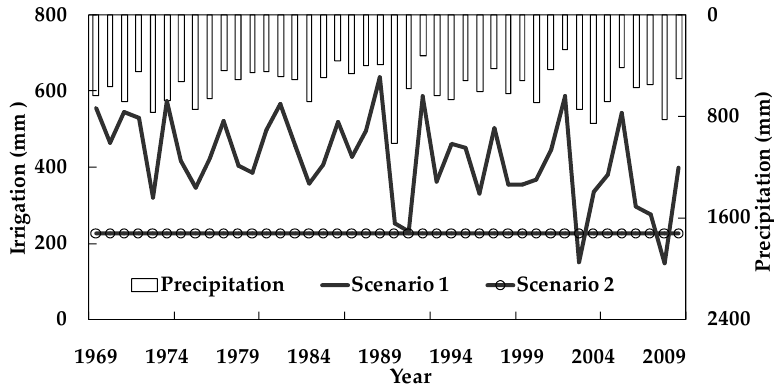
Figure 5. Annual variation in precipitation and total irrigation water under Scenarios 1 and 2 from 1969 to 2010.